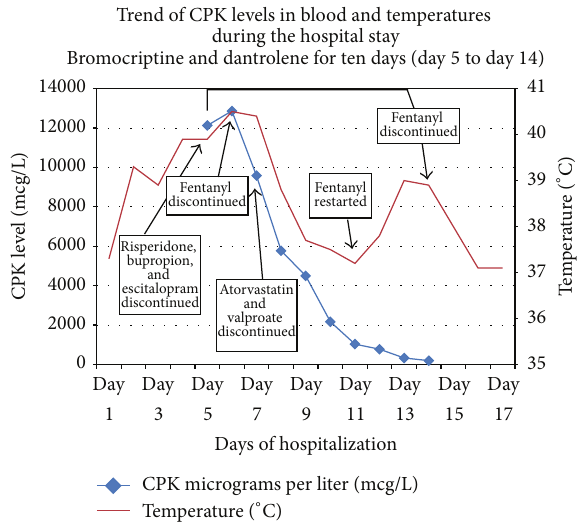
Figure 1: The trend in the serum level of creatine phosphoki- nase (CPK) in micrograms/liter (mcg/L) and body temperature in degreesCelsius( ∘ C)acrossthehospitalstay,withhighlightsonwhen certain medications were discontinued in correlation with these